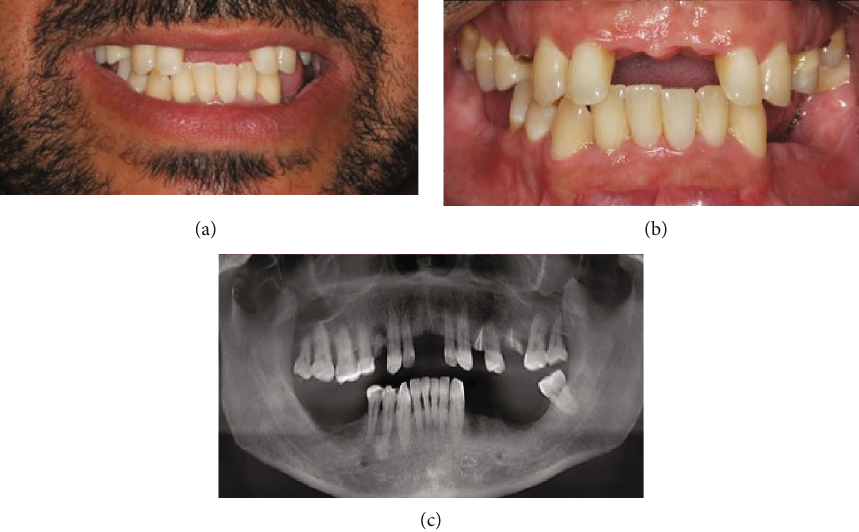
Figure 1: Patient ’ s initial photos (a, b) and panoramic radiography (c) showing the absence of several elements in both